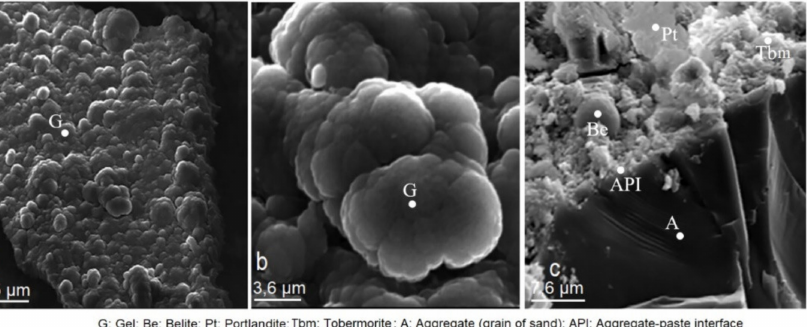
Figure 14. ( a – c ). Microphotographs of cement/mordenite specimens (CMS) taken at 7 days of